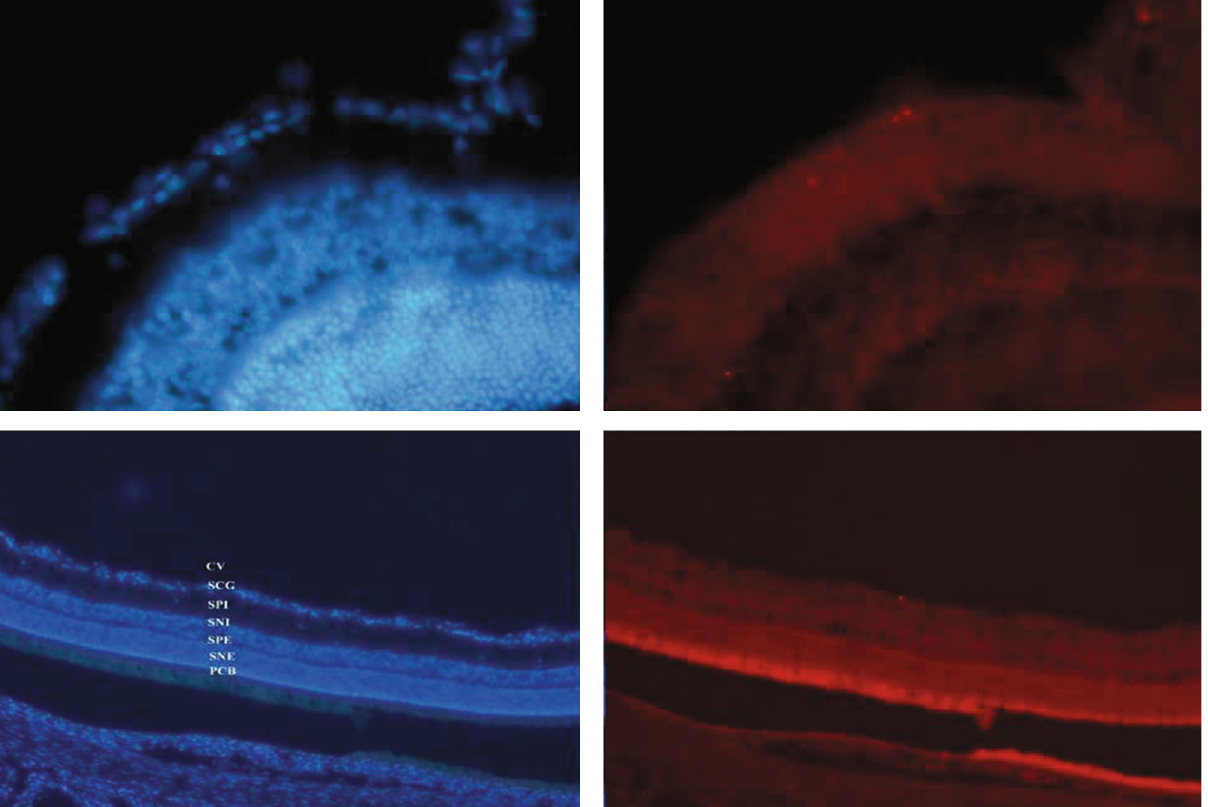
Figure 1: Histological fi ndings revealing integration of mesenchymal stem cells at the level of the ganglion cell layer in the ischemic rat retina. Retina in section counterstained with Bisbenzimide, photographed with the speci fi c fi lter for Bisbenzimide (left) and with the speci fi c fi lter for Dil (right). CV: vitreous body; SCG: ganglion cell layer; SPI: internal plexiform layer; SNI: internal nuclear layer; SNE: external plexiform layer; ENL: external nuclear layer; PRL: photoreceptor layer; RPE: retinal pigment epithelium; MSCs: mesenchymal stem